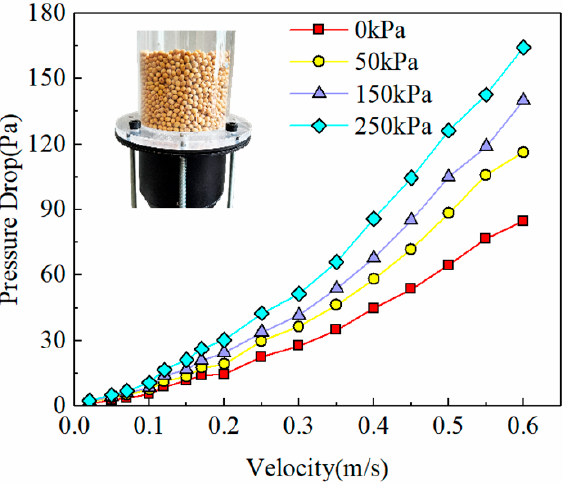
Figure 9. Pressure drop test values under different vertical pressures.